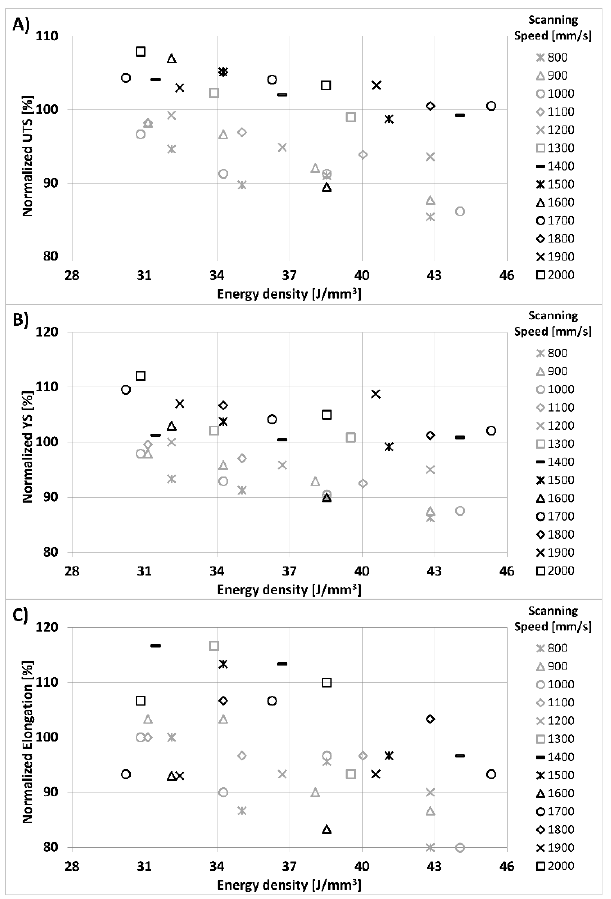
Figure 3. Variation of tensile properties versus energy density. Results refer to step 1 of the analysis. ( A ) Normalized UTS; ( B ) Normalized YS; ( C ) Normalized elongation. A slight decrease in mechanical properties with the increase in VED can be noticed.